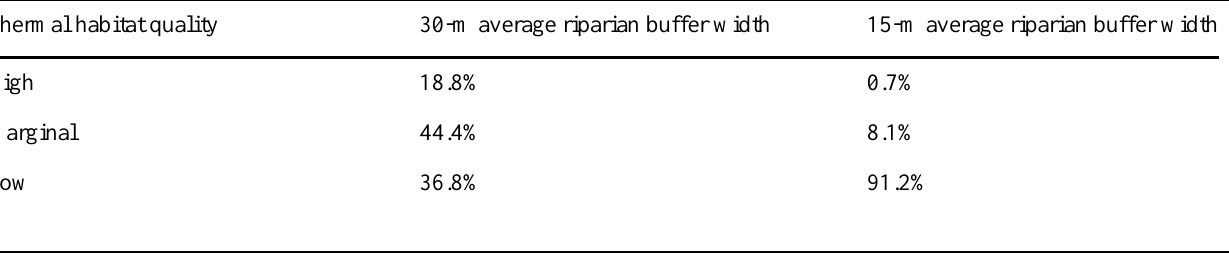
Table 7. Expected percentages of stream segments supporting high, marginal, and low quality thermal habitat (defined in Fig. 8) for 30- vs. 15-m average forested riparian buffer widths. The distribution of these streams across the trout stream network is shown in Fig.